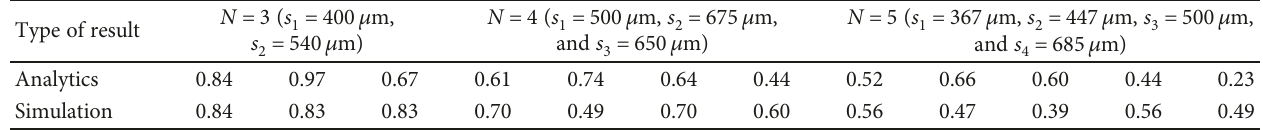
Table 1: Peak voltage of decomposition pulses,